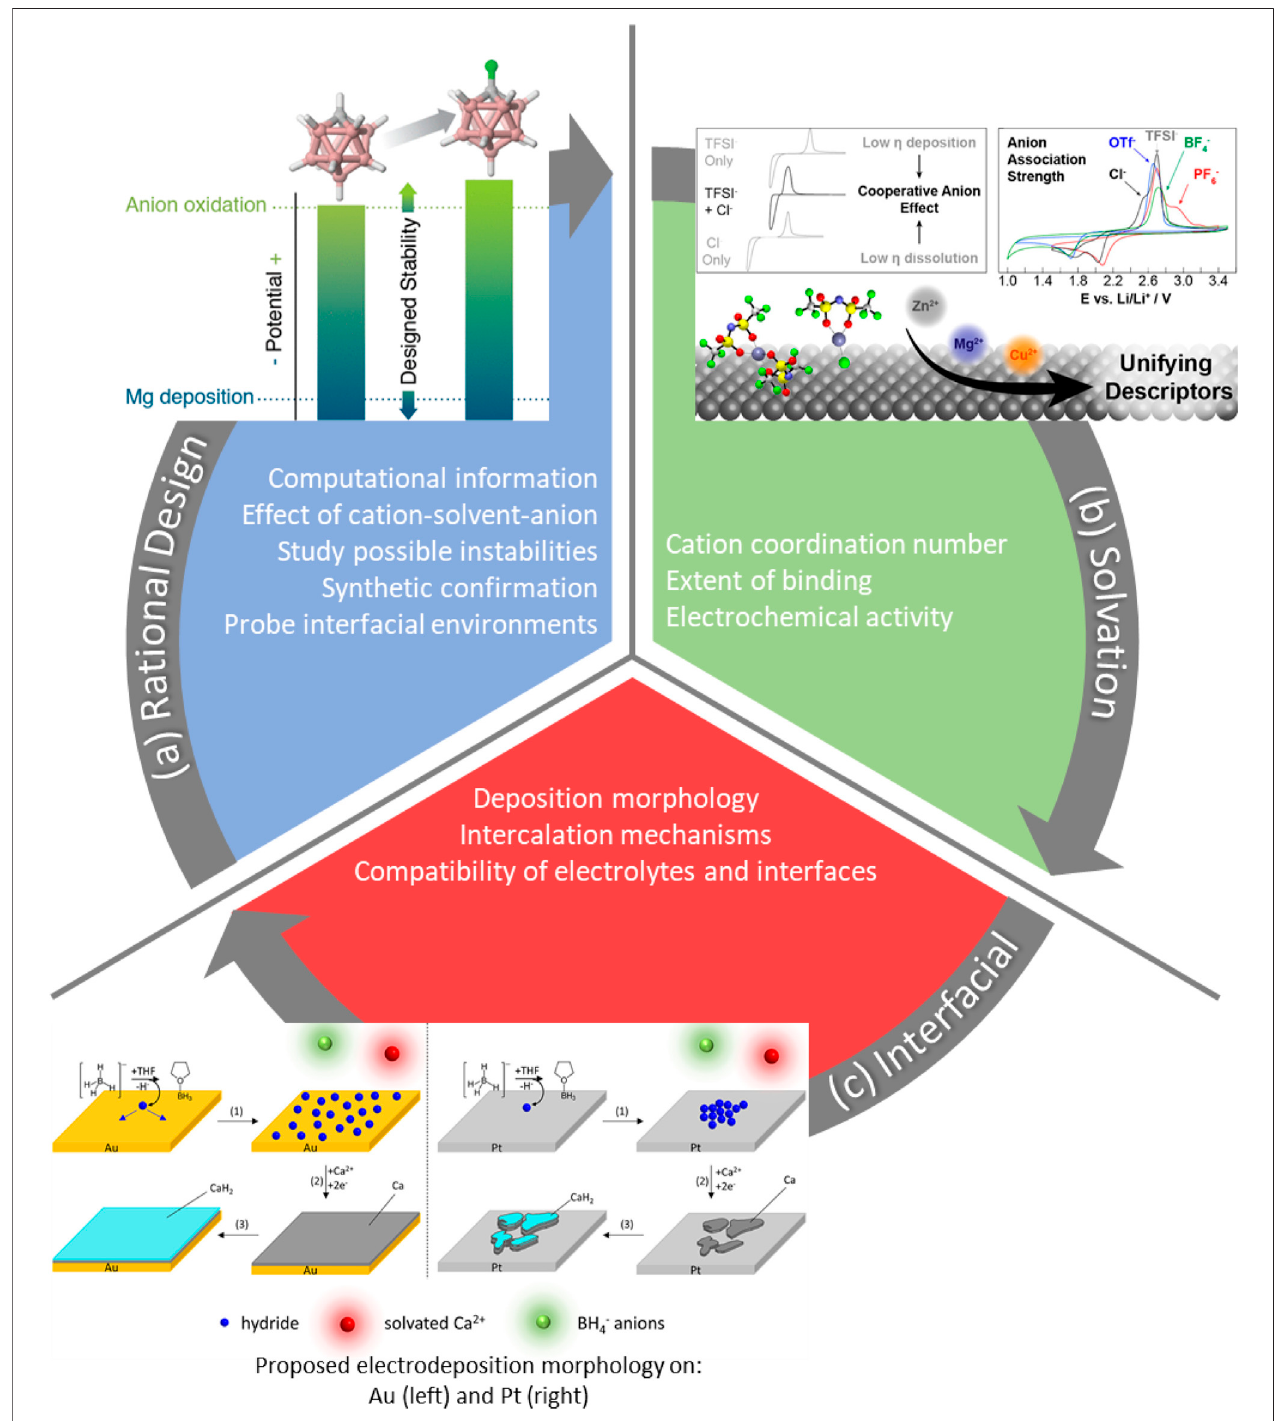
FIGURE 2 | Possible outcomes from studying a feedback loop of rational design, solvation, and interfacial understanding with case-studies from literature: (A) computationallyinformeddesignofcarbaborateelectrolytes(Hahnetal.,2018), (B) electrochemicalactivityasacauseofvariedadditivebinding(Connelletal.,2020), (C) morphological features of calcium deposition as a cause of plating surface (Ta et al., 2019) Reprinted (adapted) with permission from references (Hahn et al., 2018; Ta et al., 2019; Connell et al., 2020). Copyright (2021) American Chemical Society.